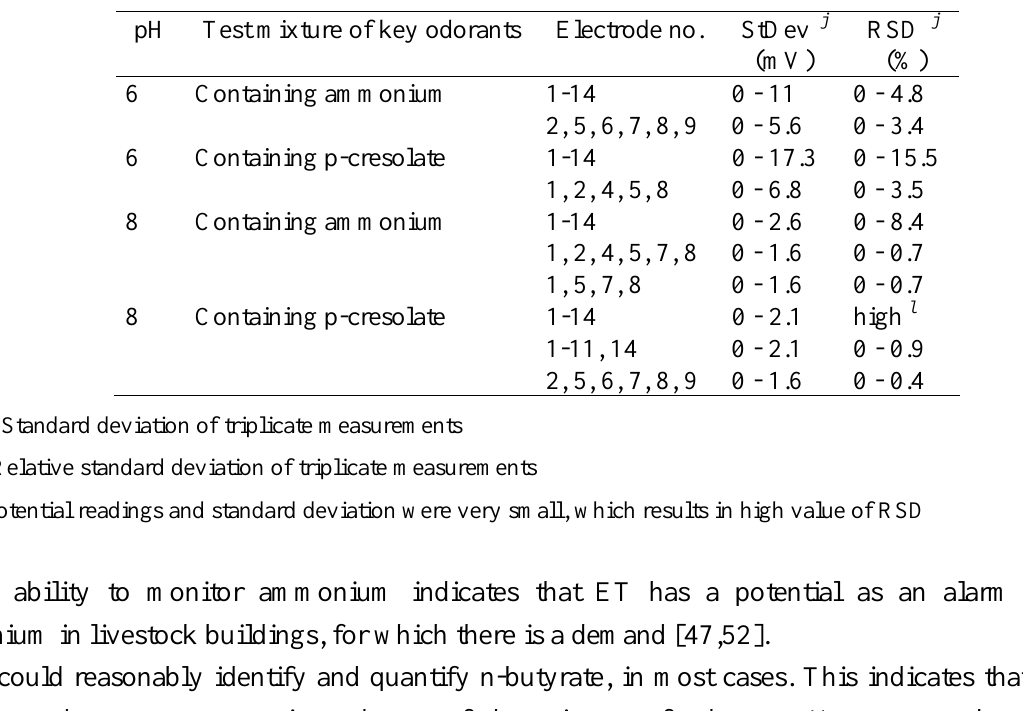
Table 5. Standard deviation (StDev) and relative standard deviation (RSD) of triplicate measurements with total and sufficient numbers of